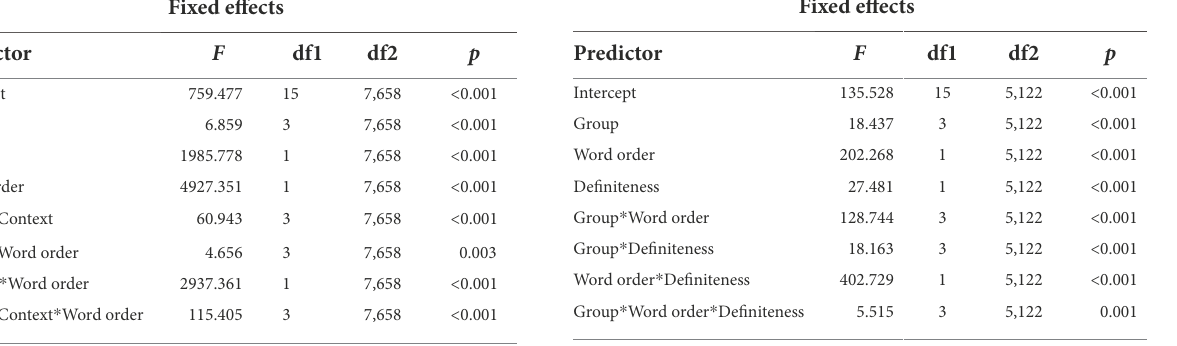
TABLE 4 Results of GLMM. TABLE 5 Results of